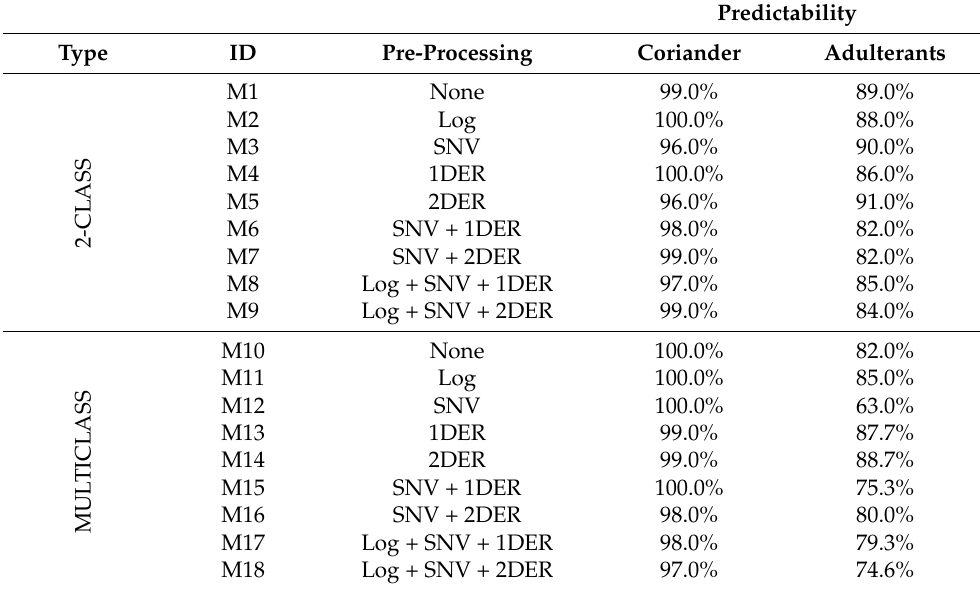
Table 3. Predictability of the two-class and multiclass models developed and externally validated ( n = 98) on the handheld SCiO device, using The Lab